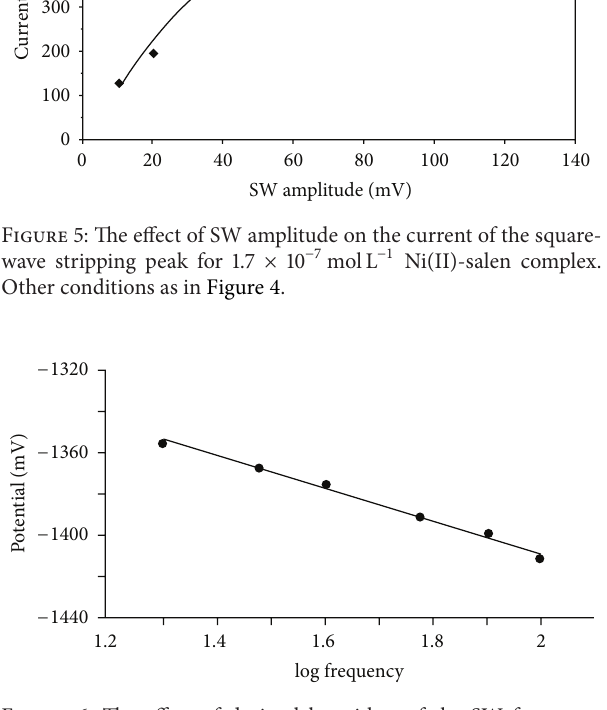
Figure 6: The effect of decimal logarithm of the SW frequency on the potential of the square-wave stripping peak for Ni(II)-salen. Other conditions as in Figure 4.